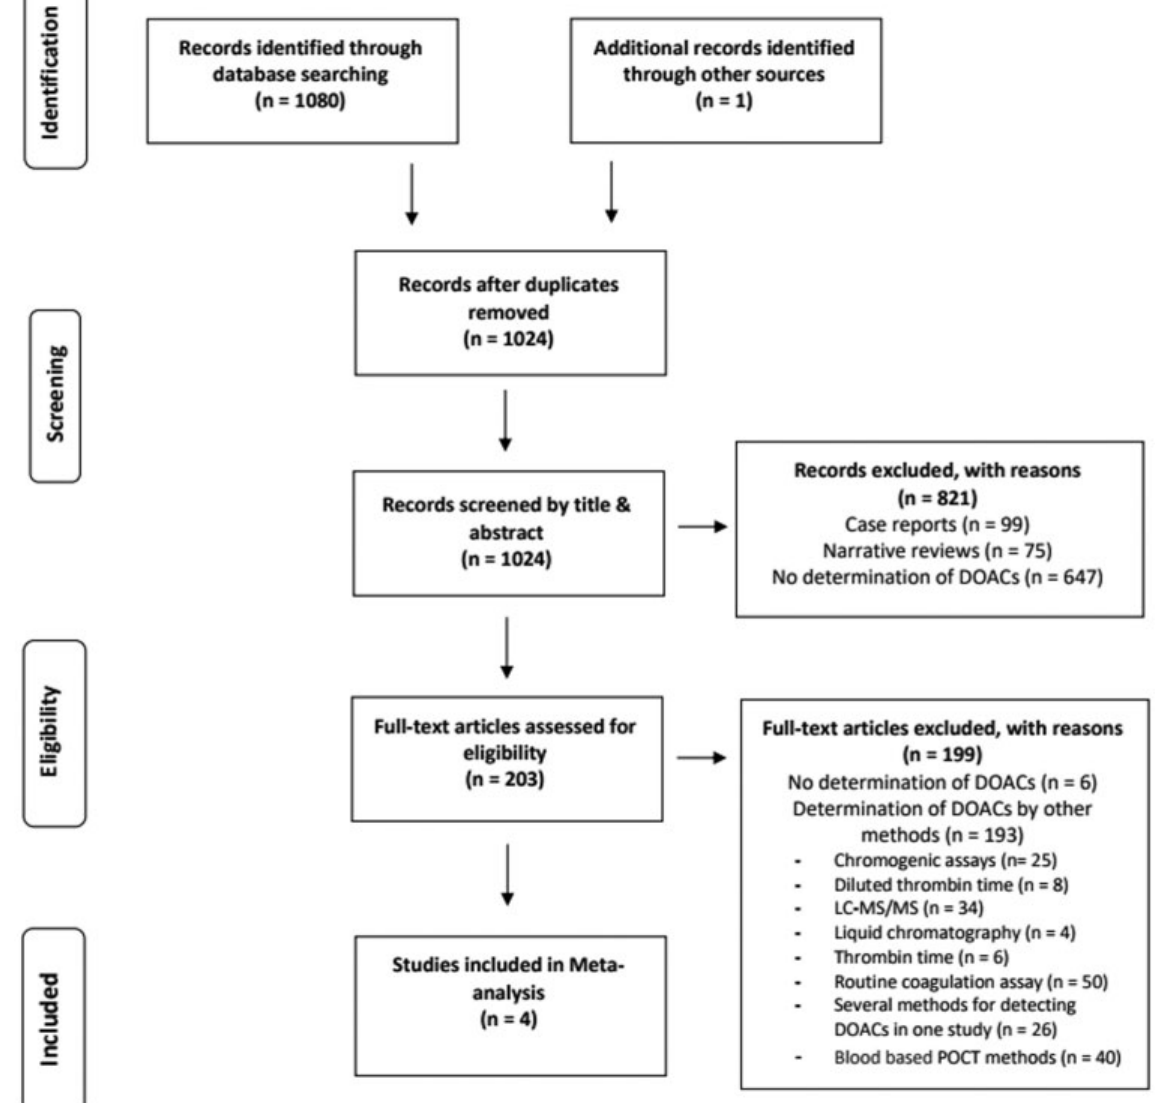
Fig. 1 PRISMA fl ow chart for selection of included